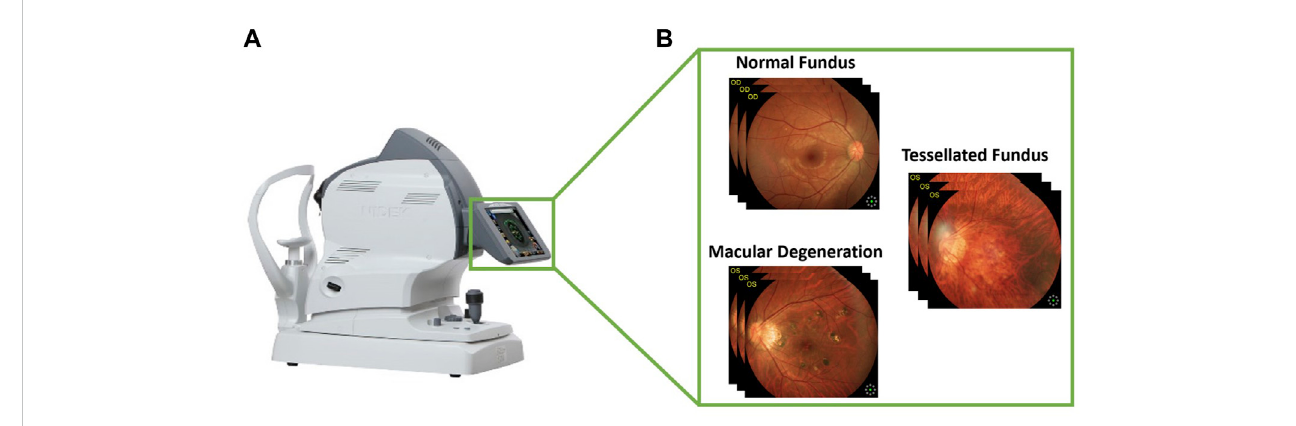
FIGURE 1 Visual representation of collecting images from fundus camera. (A) Fundus camera and (B) the fundus images according to three